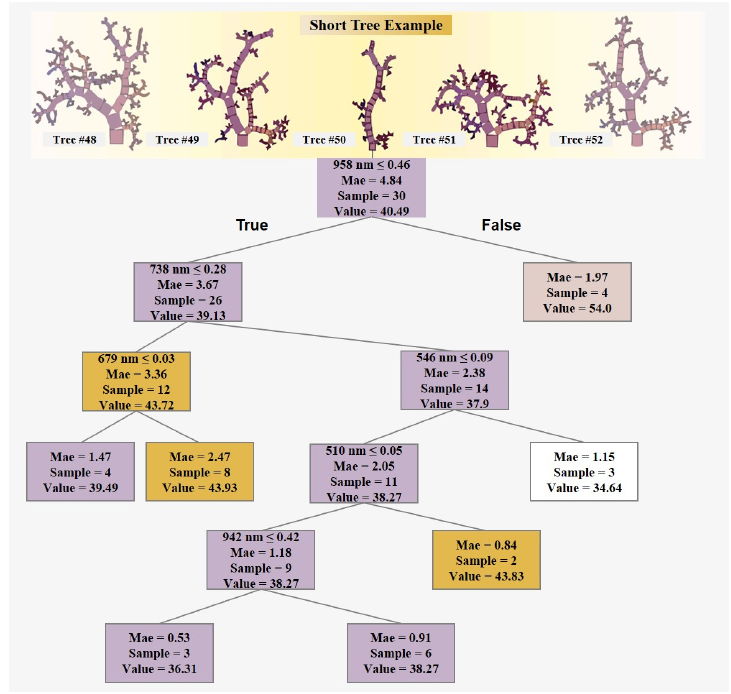
Figure 10. Example of an RF model single decision tree (initial level 6).